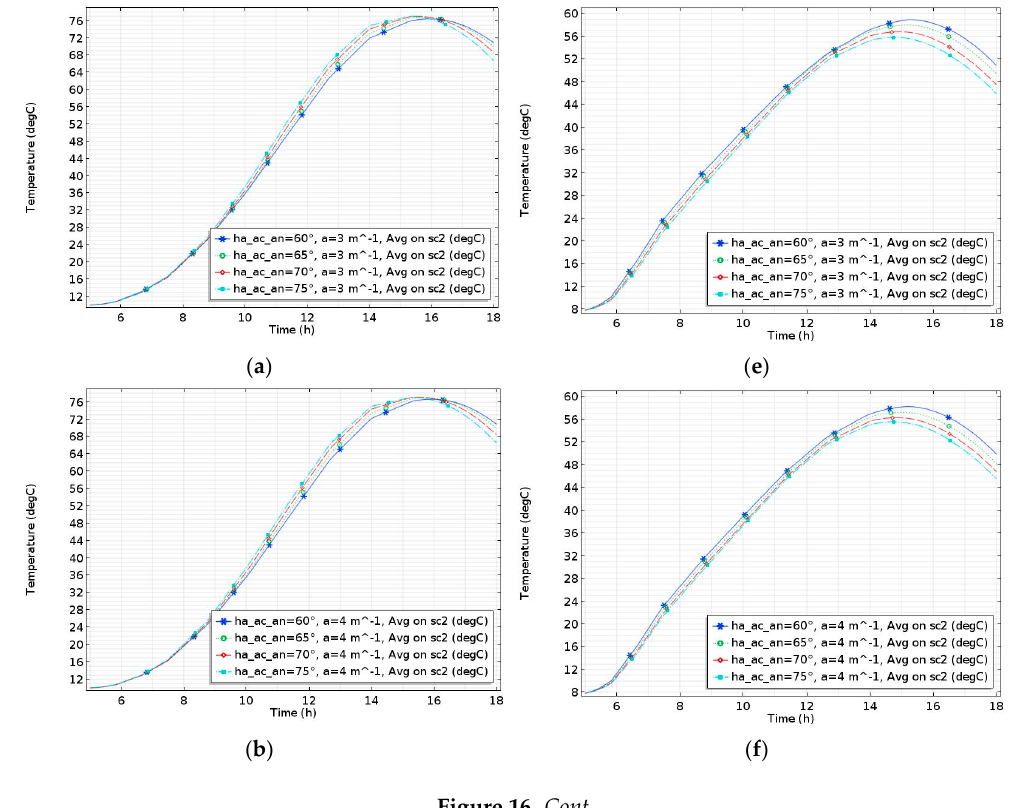
Table 8. Comparison of efficiency in the whole system for the covered CPC system by